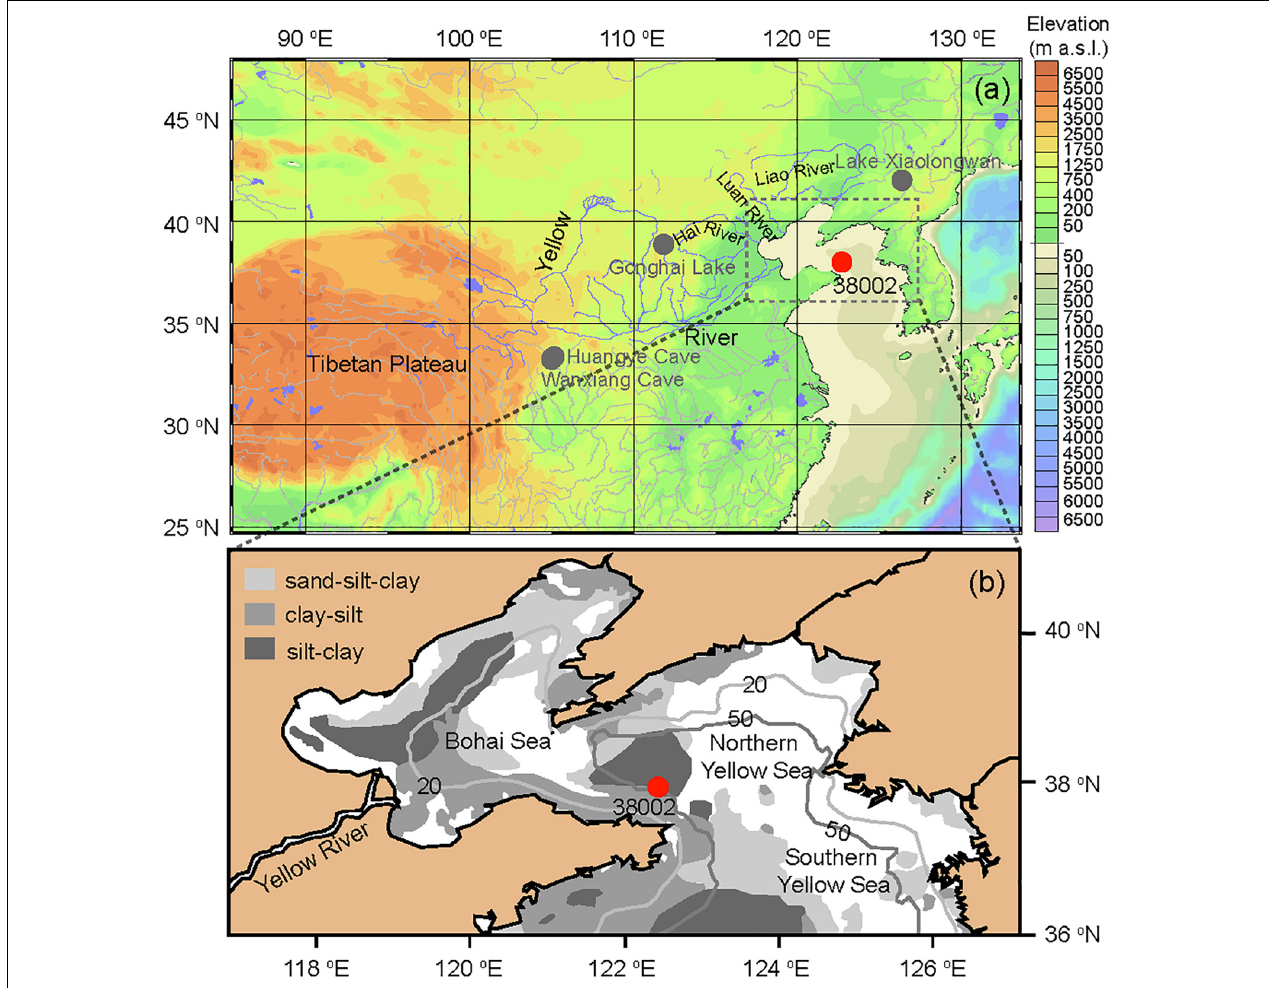
FIGURE 1 | Location of site 38002 and related sites. The base map was generated with Ocean Data View 4.0. (a) The main study sites involved in this article and (b) types of surface sediments in the Bohai Sea and the Yellow Sea.